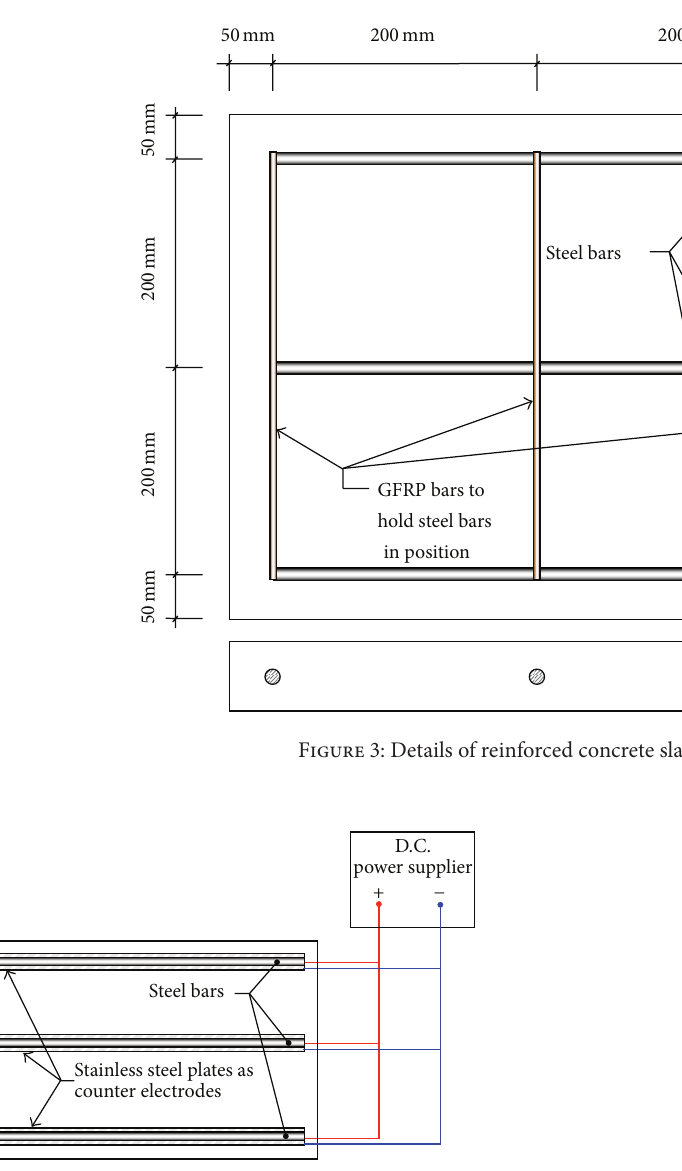
Figure 4: Setup for corroding the steel rebars.